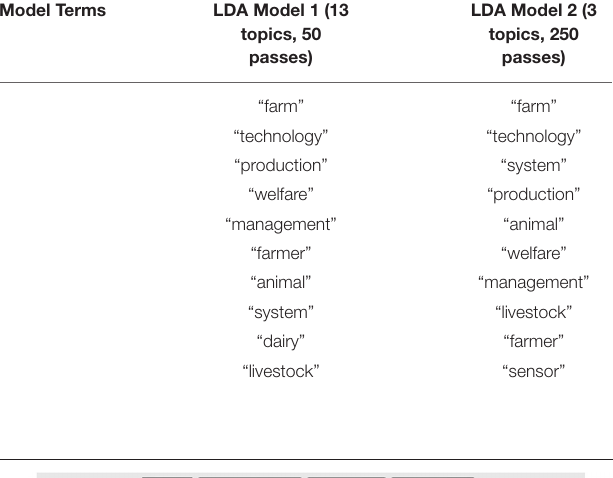
TABLE 1 | Terms from the initial output produced by LDA models generated with the different number of passes. Model Terms